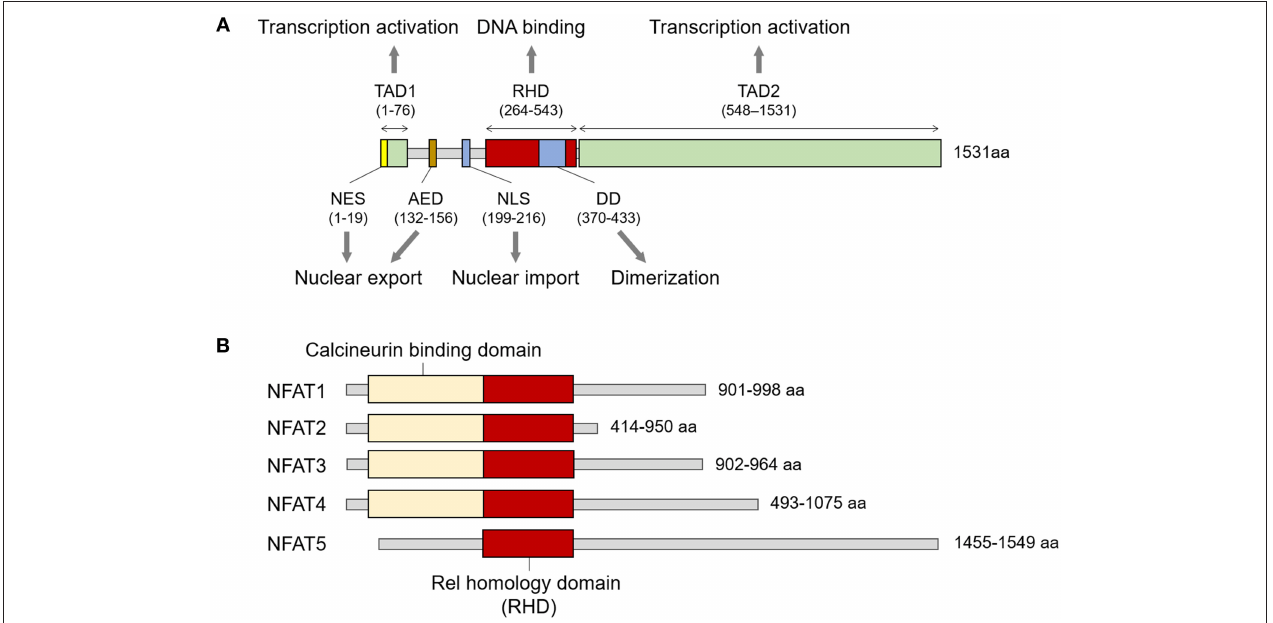
FIGURE 1 | Structure of NFAT family members. (A) Signature domains in human NFAT5 protein and their function. NFAT5 contains several functional domains including NES, TAD1, AED, NLS, RHD, DD, and TAD2. The number of amino acids in parenthesis is based on KIAA0827 (1531 amino acid; GenBank accession no. AB020634). (B) Comparison of representative structures between NFAT members. All NFAT members share the Rel homology domain, but only NFAT5 does not have a calcineurin-binding domain. The minimum and maximum numbers of amino acids among representative transcript variants are